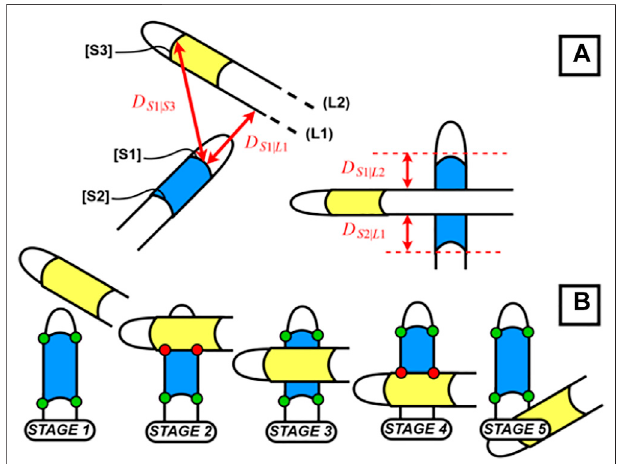
FIGURE 4 | (A) Distance between instruments; (B) crossing between